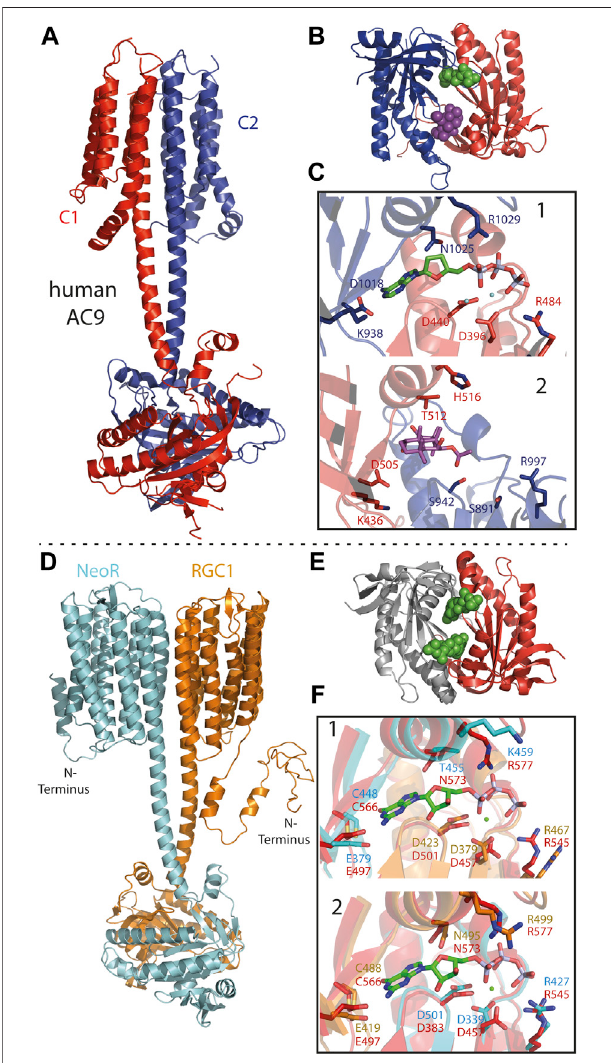
FIGURE 6 | (A) Cryo-EM structure of pseudo-heterodimeric human membrane adenylyl cyclase 9 [AC9; 6R4O (Qi et al., 2019)] with C1- and C2-subunits colored red and blue. (B) Crystal-structure of pseudo- heterodimeric AC chimera [C1a/C2a: VC1(dog)/IIC1(rat) colored as in c; 1CJU (Tesmer et al., 1999)] with substrate analog (2 ′ ,3 ′ -Dideoxy- ATP) as green and forskolin as violet spheres. (C) Close-up of the pseudosymmetric active site: 1) catalytic-site with adenine bound to C2a (blue) and phosphate to C1a (red) subunit. Catalytic relevant residues depicted as sticks. 2) Regulatory, forskolin-binding site, residues homolog to 1 shown. Despite the different models used in A and B the general architecture of the sites 1 and 2 remains similar. (D) Structural model of the NeoR/RGC1 heterodimeric complex as derived from Alphafold2 (Mirdita et al., 2021), conducted by E. Peter (Humboldt University Berlin). Color-code: NeoR (cyan) and RGC1 (orange). (E) Crystal-structure of the cyclase-core of homodimer RGC from C. anguillulae [6SIR (Butryn et al., 2020)] GTP substrate drawn as green spheres indicating the two symmetric catalytic sites at the dimerization interface. (F) Structural overlay of the NeoR/RGC1 pseudosymmetric catalytic sites (colored as in D) to the homodimer from C. anguillulae (red) with bound GTP and Ca 2+ (green spheres). Site 1: guanine-base bound to NeoR, phosphate bound to RGC1; Site 2 with opposite